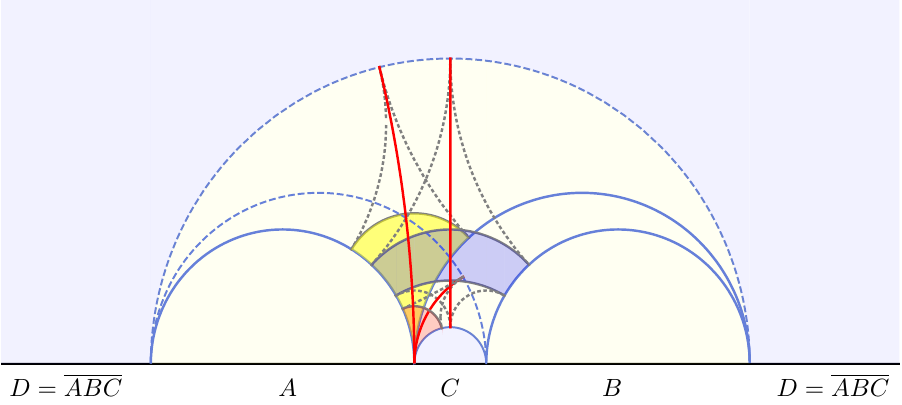
Figure 12 . In this (cid:12)gure we plot the minimal surfaces of all the individual regions as well as the di(cid:11)erent pairwise combinations. In particular we are interested in AB , AC , and ABC . We represent the di(cid:11)erent (cid:13)ows whose (cid:13)ux compute the mutual information between A and B , A and C , and A and BC in blue, red and yellow,